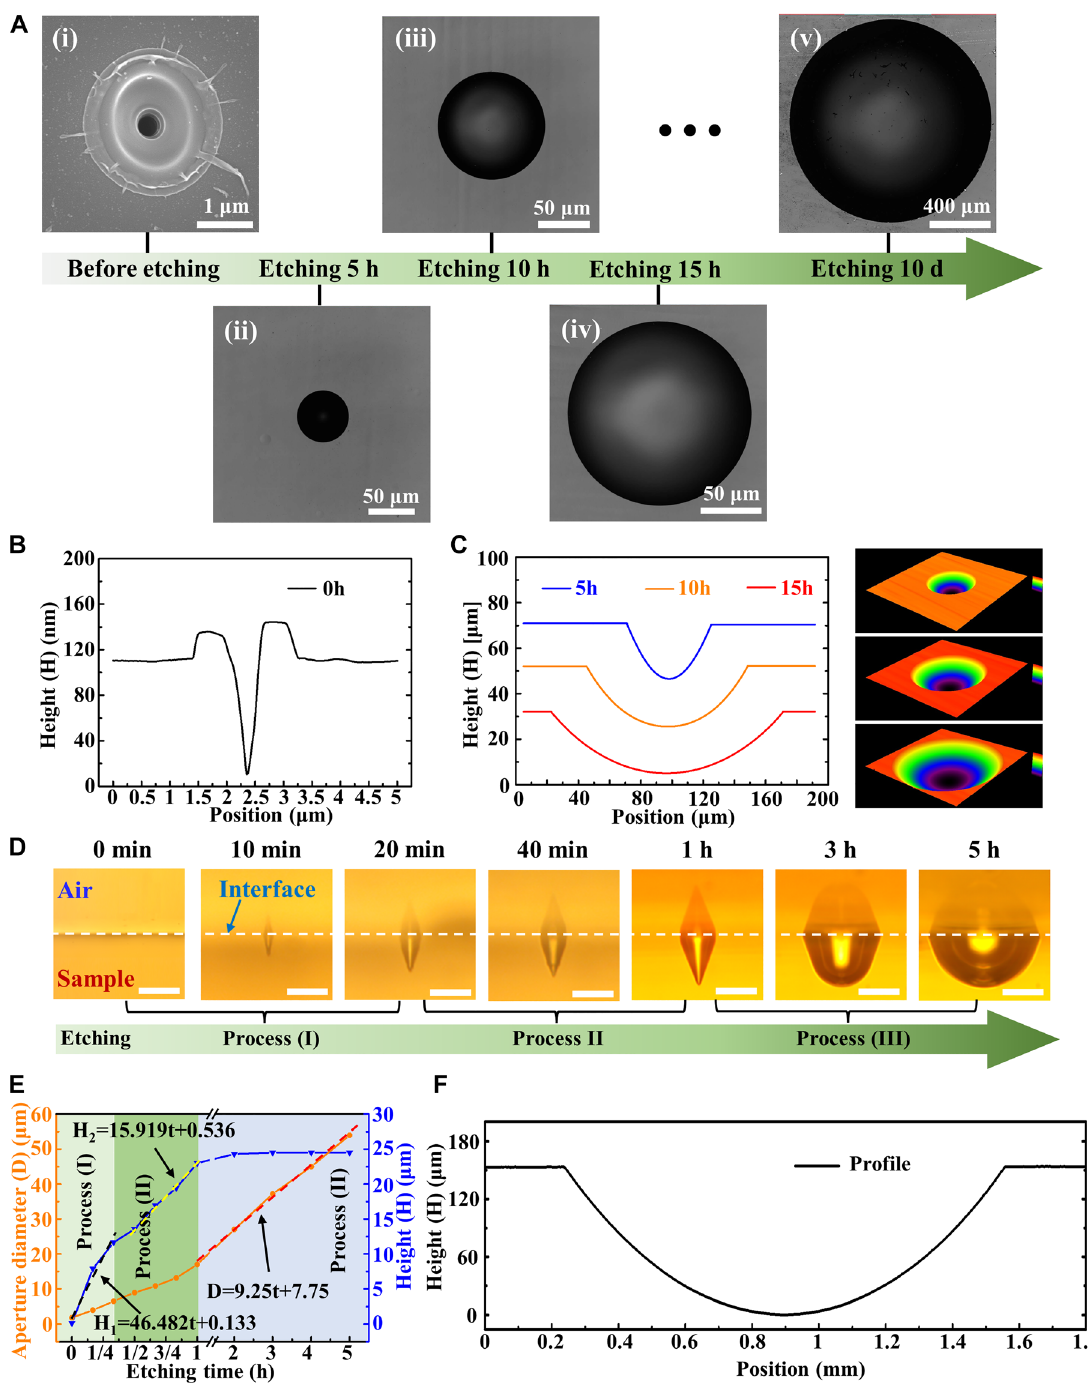
Figure 4: Process of microlens formation through BLB-assisted wet etching. (A) SEM image of the structure before etching (i), and LCSM images of the structure after etching for 5 h (ii), 10 h (iii), 15 h (iv), and 10 days (v), respectively.(B)Pro fi leofthestructurebeforeetchingmeasuredbyusingatomforcemicroscopy.(C)Pro fi lesand3Dviewofthestructureafter etchingfor5h,10h,and15h measured byusingLCSM.(D)OTMimagesof structuremorphologyevolutionwithetchingtimefrom0minto 5h. Thescalebaris20 μ m.Thedashedlinerepresentstheinterfacebetweenthesampleandtheair.(E)Structuralaperturediametersandheights that vary with etchingtime. The black dashed line and yellow dashedline representthe function of structuralheight increasingwith etch time in Process I and Process II, respectively, and the red dashed line represents the function of structural aperture diameter increasing with etch time in Process III. (F) Pro fi le of the structure after etching for 10 days measured by using